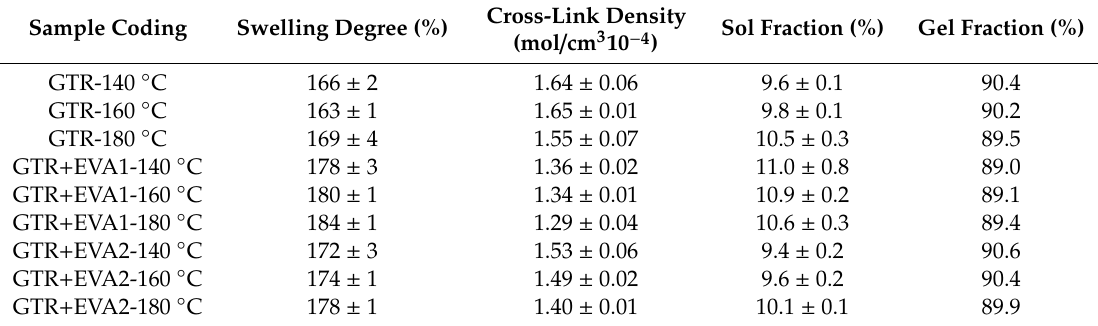
Table 5. Swelling degree, cross-link density, sol, and gel fraction of GTR modified by ethylene vinyl acetate